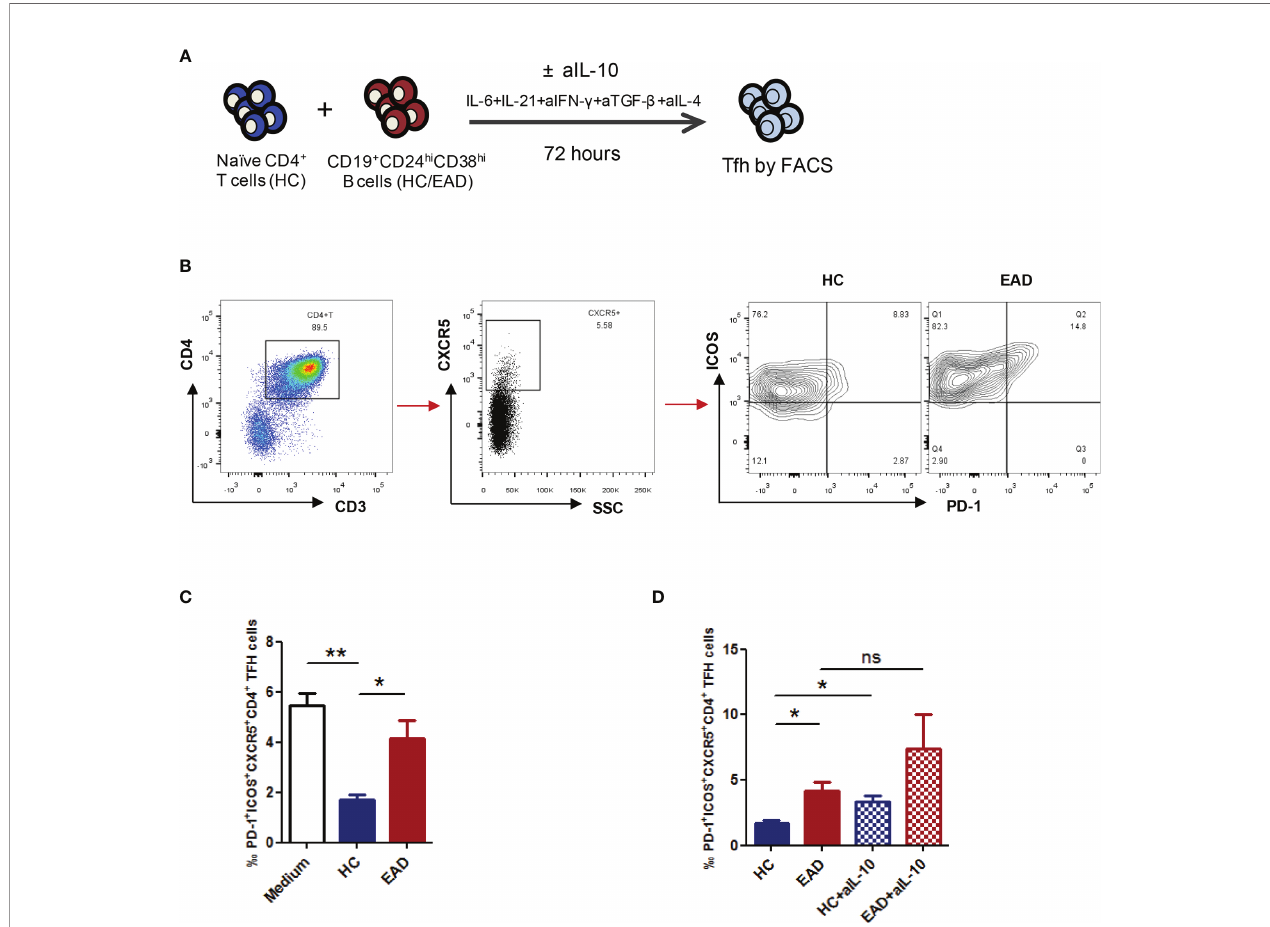
FIGURE 4 | Breg cells from patients with EAD are less able to suppress differentiation of Tfh cells. (A) CD19 + CD24 hi CD38 hi B cells were isolated from HC and patients with EAD by fl ow cytometry, and CD4 + naïve T cells were isolated from HC by MACS. Cells were co-cultured for 72 h under Tfh-polarizing conditions. (B, C) The percentage of PD-1 + ICOS + CXCR5 + CD4 + Tfh cells was signi fi cantly reduced upon co-culture with Breg cells from HC (n = 4) compared with blank controls (group medium, n = 4), but not upon co-culture with Breg cells from EAD patients (n = 4). (D) The suppressive effect of Bregs on Tfh cell differentiation decreased signi fi cantly after adding anti-IL-10 neutralizing antibody to the co-culture system (n = 4). Data are expressed as the means ± SEM. *P <0.05 and **P <0.01. ns, not signi fi cant (Mann-Whitney U -test). Data are representative of three independent